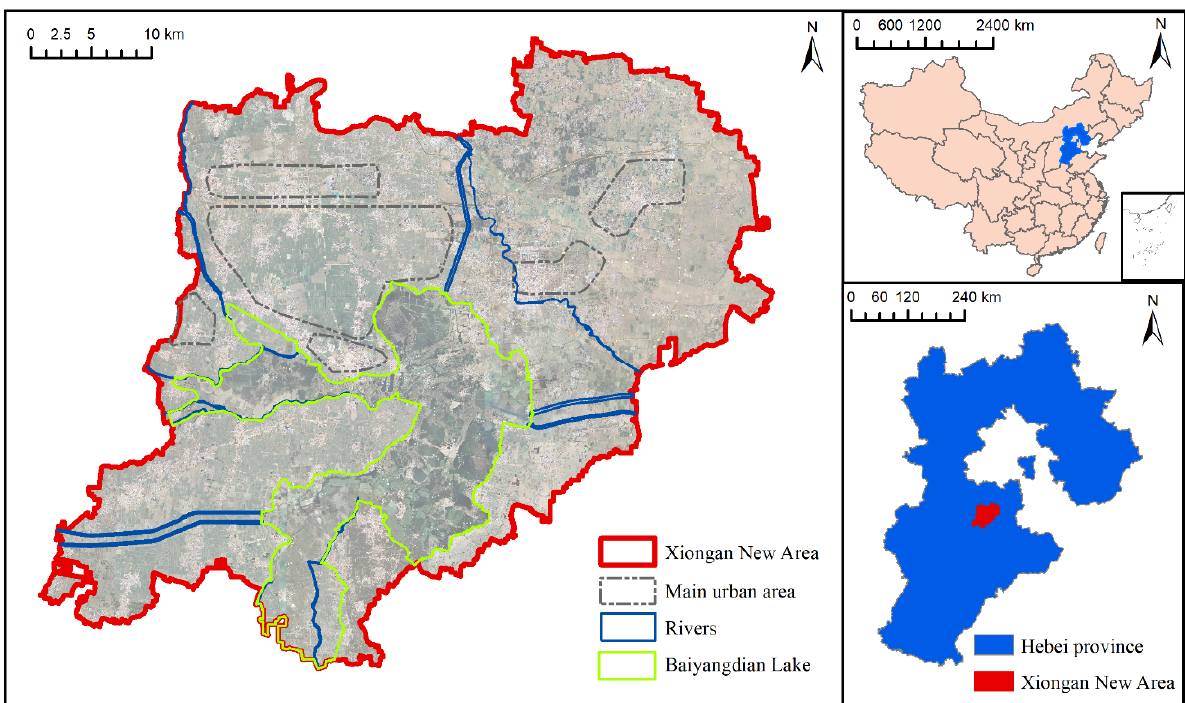
Figure 1. Location of the study area. The main urban area represents the area of the Xiong’an New Area that is planned for future urban development, where a large number of urban water systems and wetlands will be built.